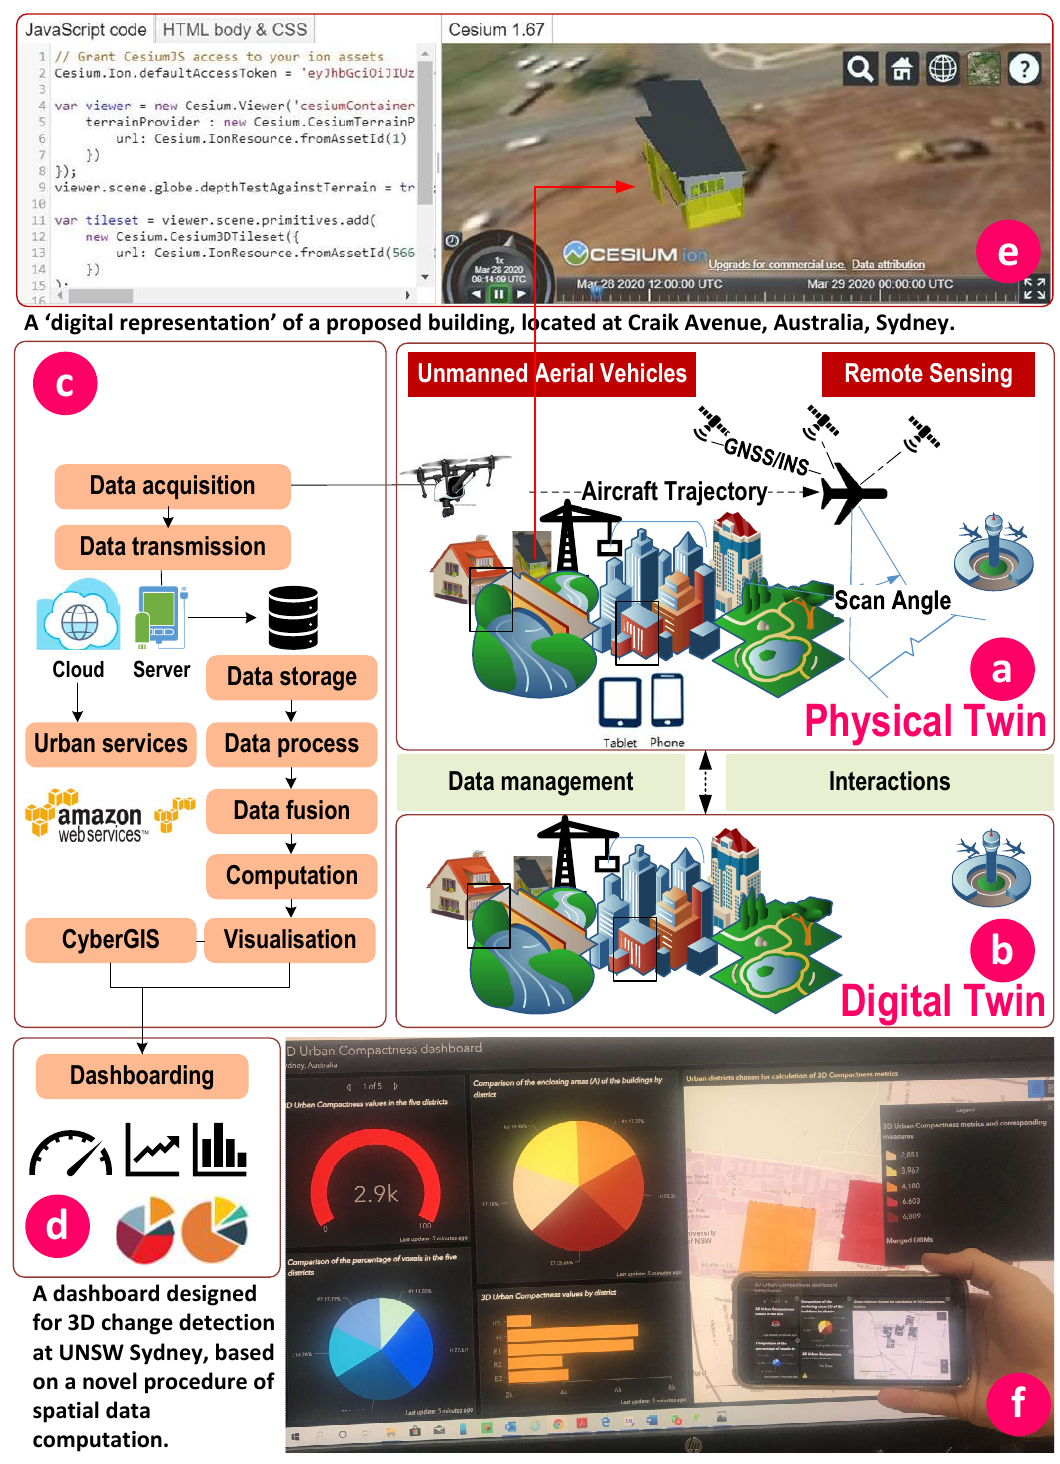
Figure 1. Demonstrating digital–physical twin at the city scale, ( a ) city physical twin; ( b ) city digital twin; ( c ) data management and interactions; ( d ) dashboard development based on computation; ( e ) integration of Building Information Modelling (BIM) and Geographic Information Systems (GIS) for a digital model of a proposed building; ( f ) dashboard developed by the first author used for making better insights from